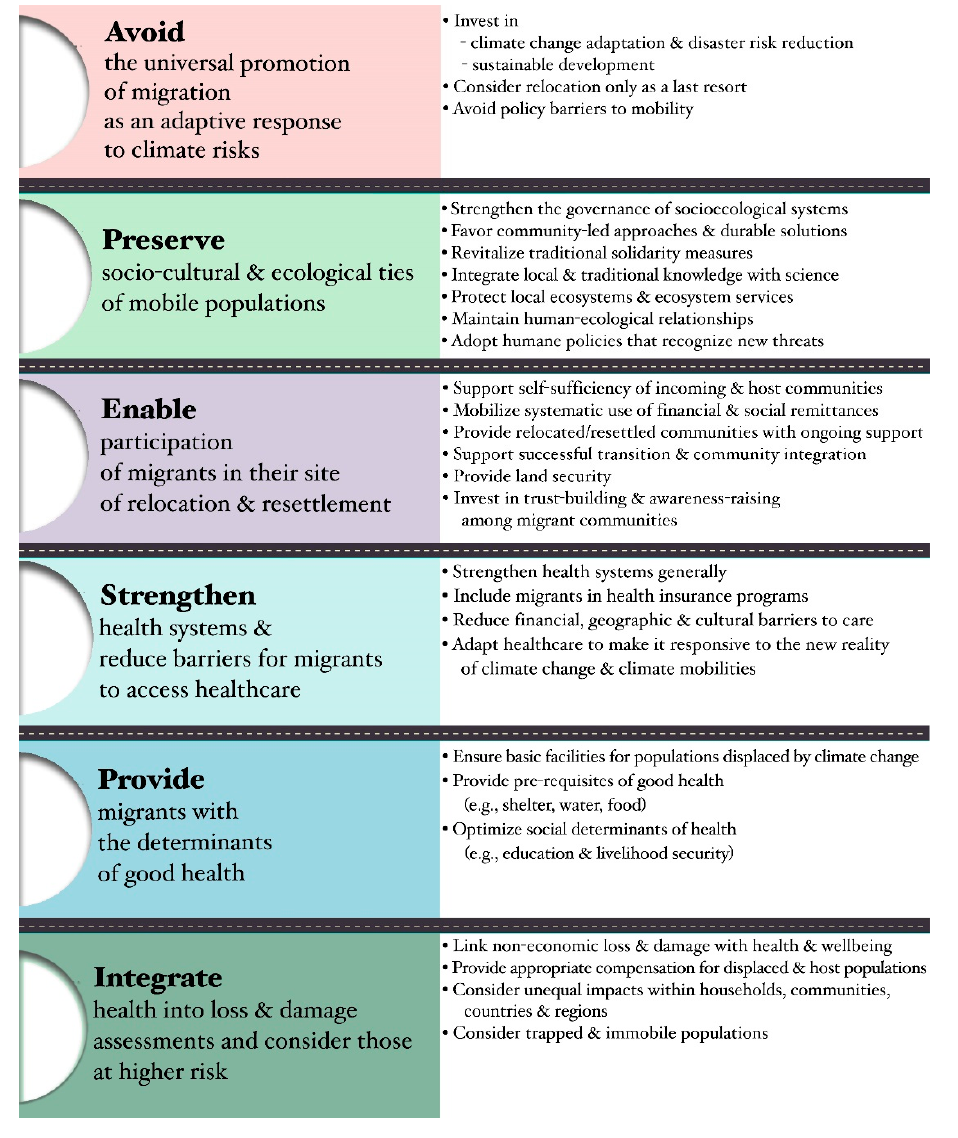
Figure 5. Policy recommendations synthesis.